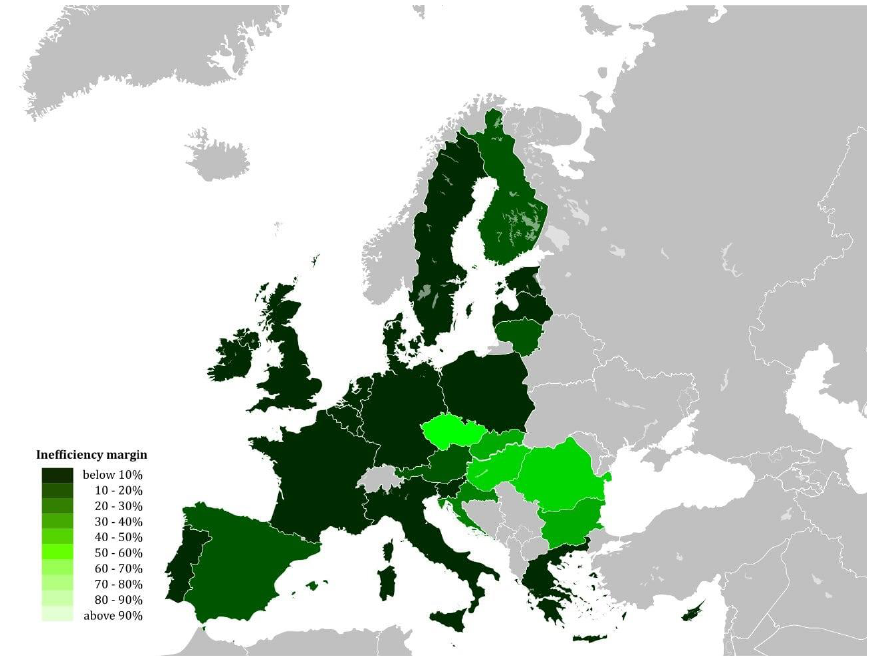
Figure A2. Efficiency scores across countries in 2017 on a map of Europe.